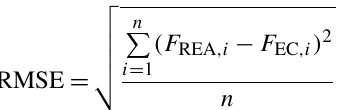
One simulation was run as a control with a null